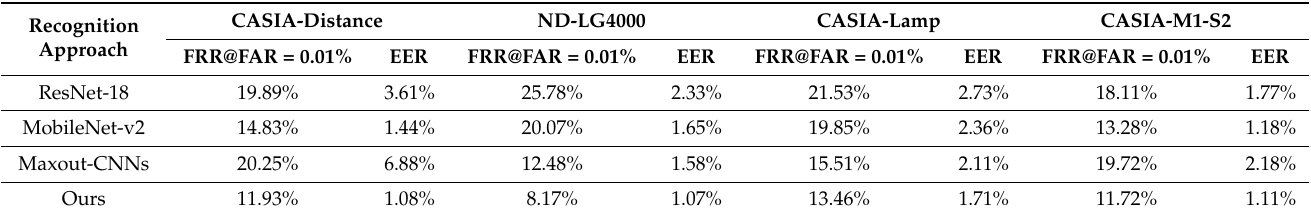
Table 4. Comparisons between different iris verification networks.